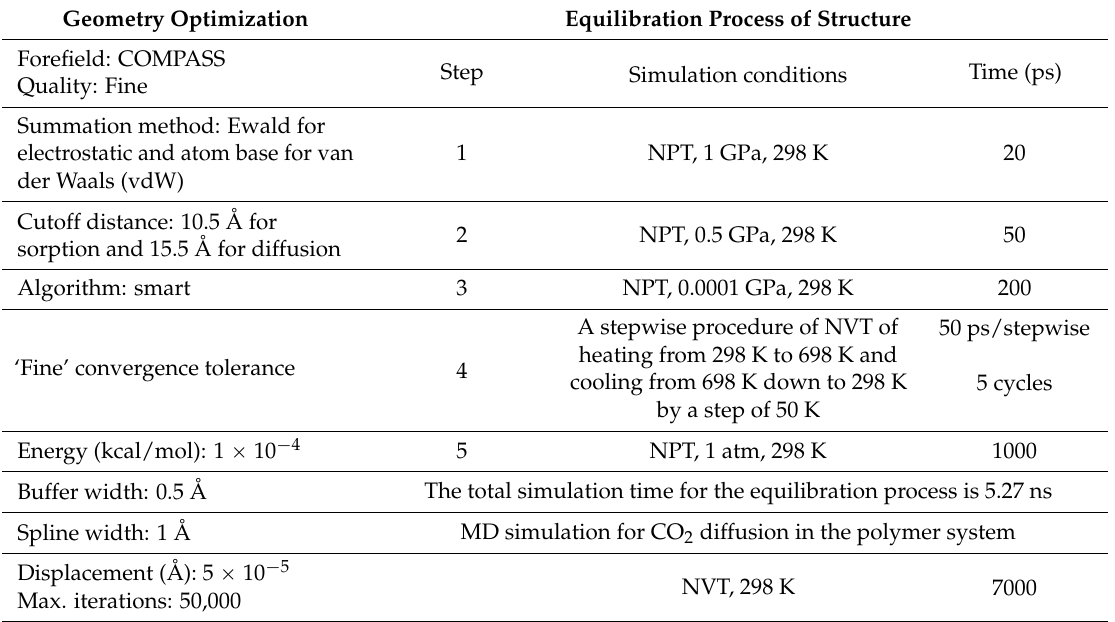
Table 1. Settings for geometry optimization and equilibration process of polymer systems and for the MD simulation of CO 2 diffusion in polymer systems. Geometry